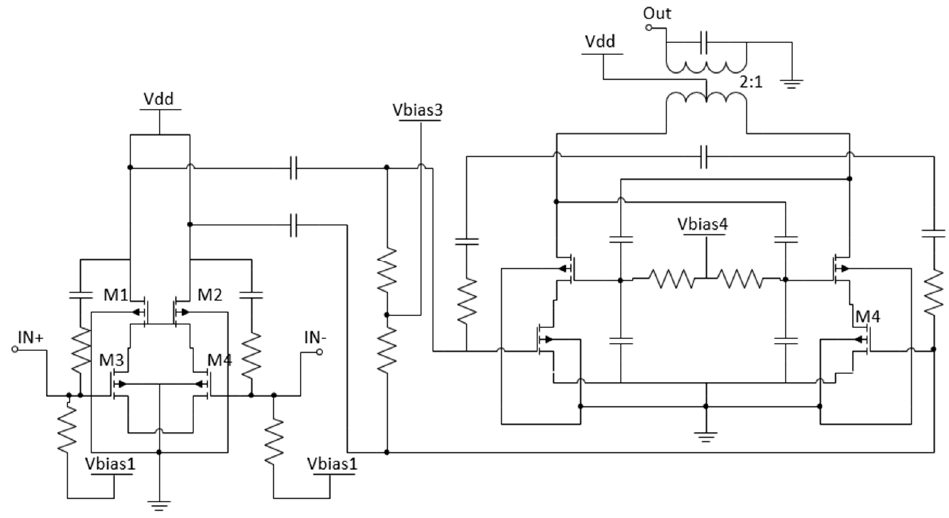
Figure 10. Schematic of proposed capacitive-cross-coupled CMOS PA [38].